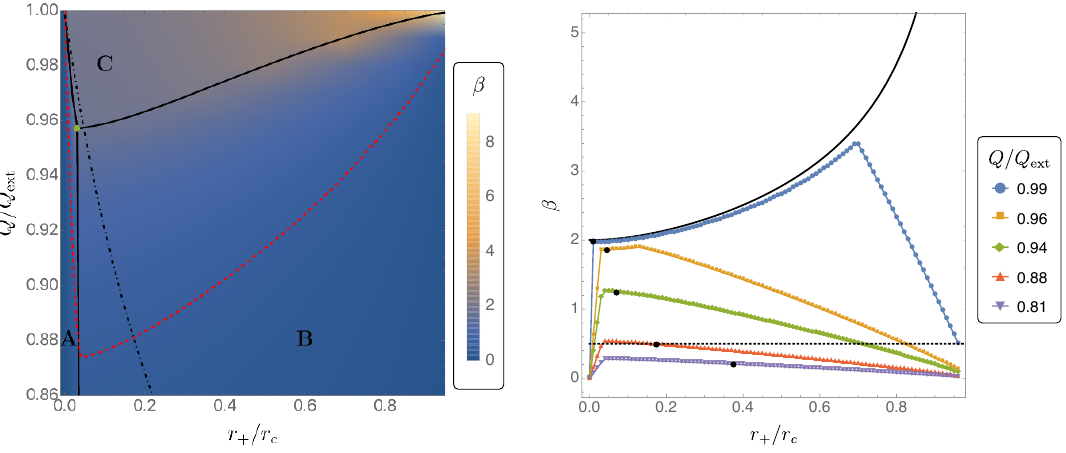
Figure 8 . Value of (cid:12) for RNdS black holes. Left panel. In region A the dS family dominates (i.e. the slowest decaying quasinormal mode is a dS mode), in region B the photon sphere family dominates, and in region C the near-extremal family dominates. The red dashed curve corresponds to the critical value of (cid:12) = 1 = 2. Above this line one has (cid:12) > 1 = 2 so the Christodoulou formulation of strong cosmic censorship is violated for smooth initial data. The black dashed dotted line corresponds to lukewarm black holes. Right panel. (cid:12) against r + =r c for di(cid:11)erent values of Q=Q ext . The discontinuities in the derivatives of these curves occur across the boundaries of the di(cid:11)erent regions A; B; C . Note that (cid:12) > 2 su(cid:14)ciently close to extremality, and large near-extremal black holes can have arbitrarily large (cid:12) . The black curve is the analytical prediction for near-extremal modes and the black disks correspond to lukewarm black holes.